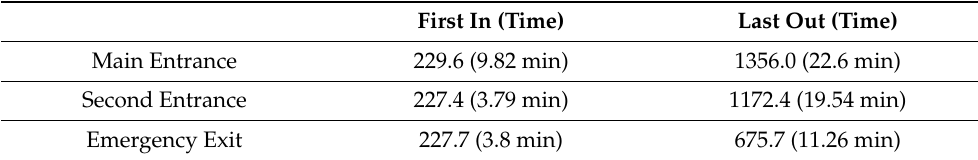
Table 5. Time spent by the first and last occupants for Scenario 2 in Simulation